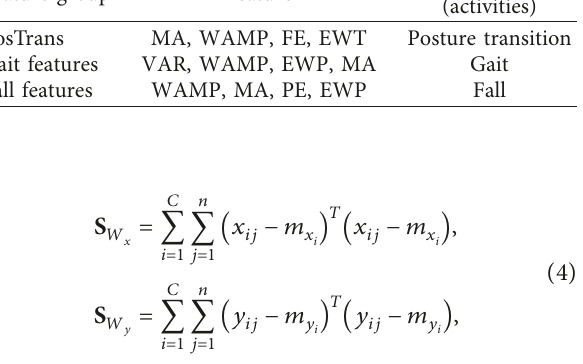
Figure 6: F2 of four